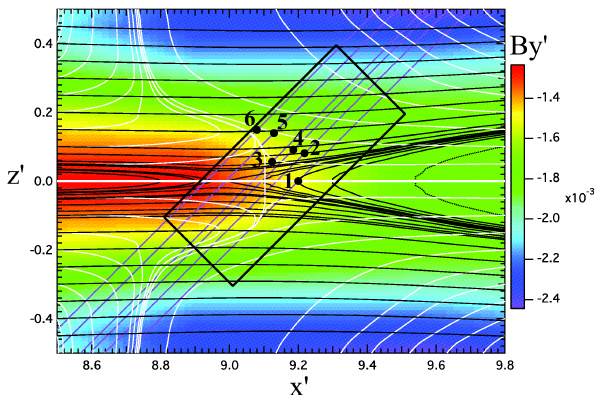
Figure 2. Plot of magnetic field lines (black) and streamlines (white) in the x z � �� plane 555 Fig. 2. Plot of magnetic field lines (black) and streamlines (white) of the simulation, with the extremely weak, normalized (in units of 20 nT) field in the x 0 − z 0 plane of the simulation, with the extremely weak, nor- that plane shown in color. Also shown are six simulated spacecraft paths through the 557 malized (in units of 20nT) field B y 0 in that plane shown in color. vicinity of the reconnection site. The spacecraft paths are in reality inclined by 19.5° to the 558 Also shown are six simulated spacecraft paths through the vicinity x z � �� plane. The simulated spacecraft 1 - 4 form a tetrahedron configuration while the 559 of the reconnection site. The spacecraft paths are in reality inclined spacecraft 5 and 6 are used as auxiliaries for verification of the reconstruction results. The 560 by 19.5 ◦ to the x 0 − z 0 plane. The simulated spacecraft 1–4 form a region to be reconstructed is within the black box. In the simulation, the y � axis is the 561 tetrahedron configuration while the spacecraft 5 and 6 are used as axis of approximate invariance. 562 auxiliaries for verification of the reconstruction results. The region to be reconstructed is within the black box. In the simulation, the y 0 -axis is the axis of approximate